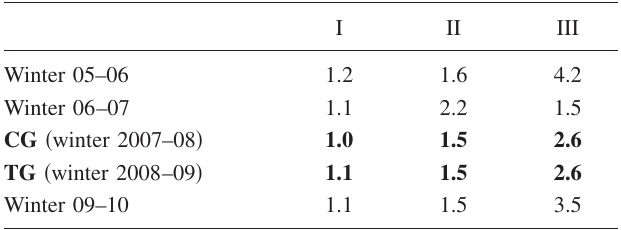
TABLE V. Admission cutoff grades for students beginning a medical course in Munich in the last five years . Grades are given in the German style: 1 (cid:1) highest (cid:2) to 6 (cid:1) lowest (cid:2) ; passing grades 1–4. In selection round I 20% of the available places are assigned solely by the students’ grades. The next 60% of places are awarded in round